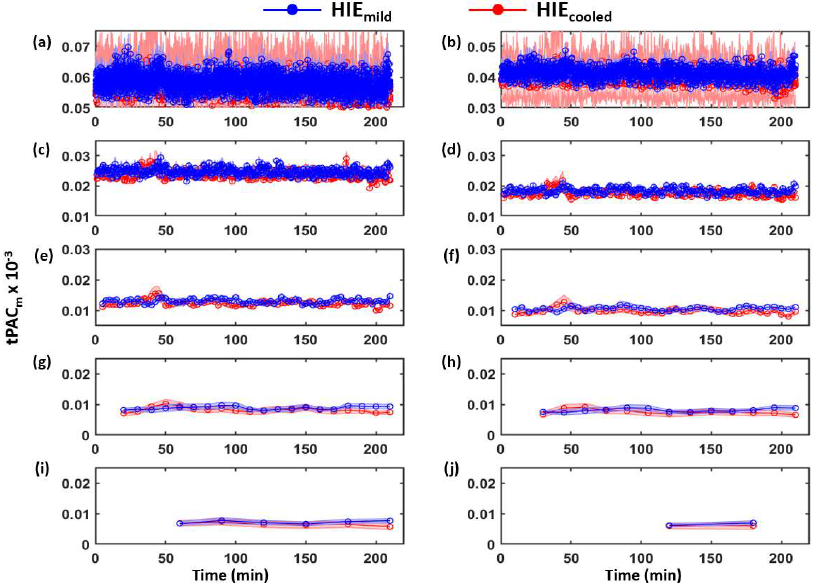
Figure A3. tPAC m indexes at C4 from HIE mild (blue) and HIE cooled (red) under ( a ) 10 s; ( b ) 20 s; ( c ) 1 min; ( d ) 2 min; ( e ) 5 min; ( f ) 10 min; ( g ) 20 min; ( h ) 30 min; ( i ) 60 min; ( j ) 120 min window sizes. Each point denotes the cross-neonate average of tPAC m for the group at different time in the 6 HOL. The shaded error bar indicates the standard error of the mean. t = 0 indicates the start of EEG re- cording.